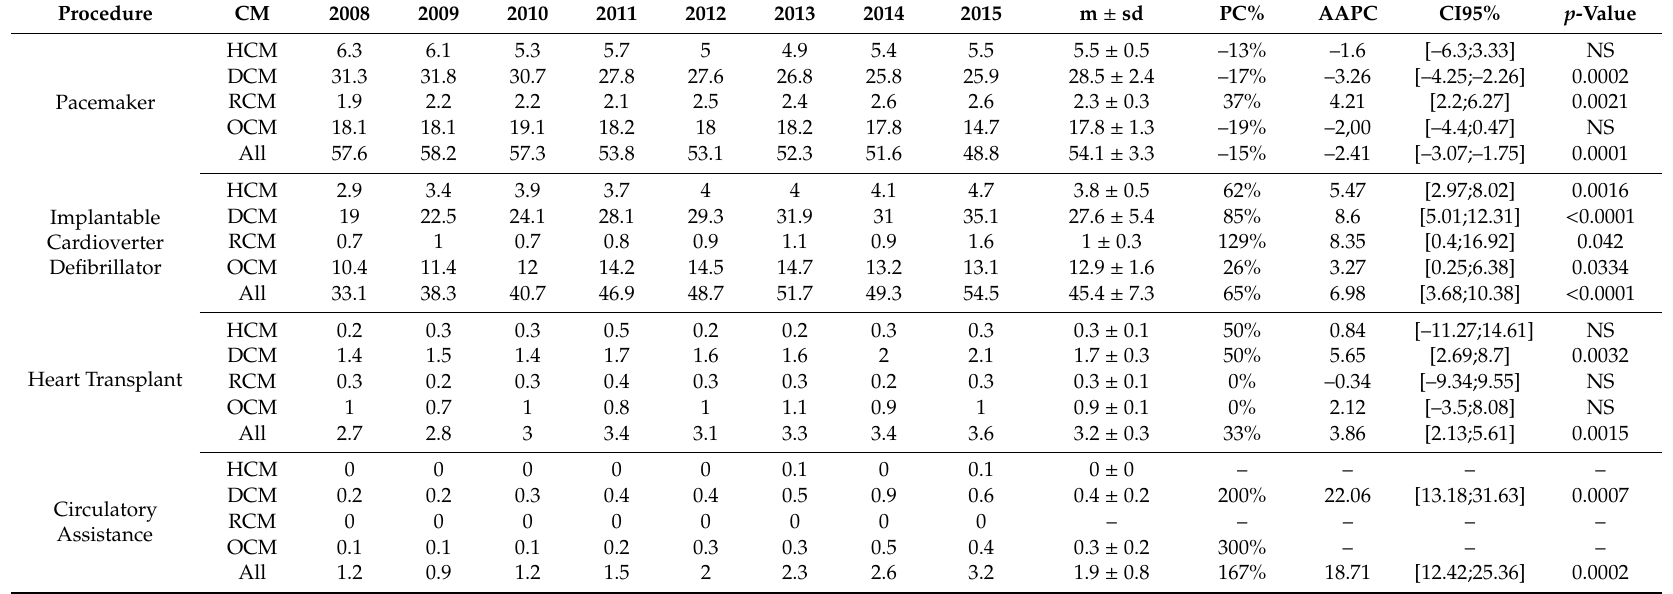
Table 3. Temporal variations of inpatient prevalence of invasive procedure (per million inhabitants), by type of procedure and cardiomyopathy, over the period